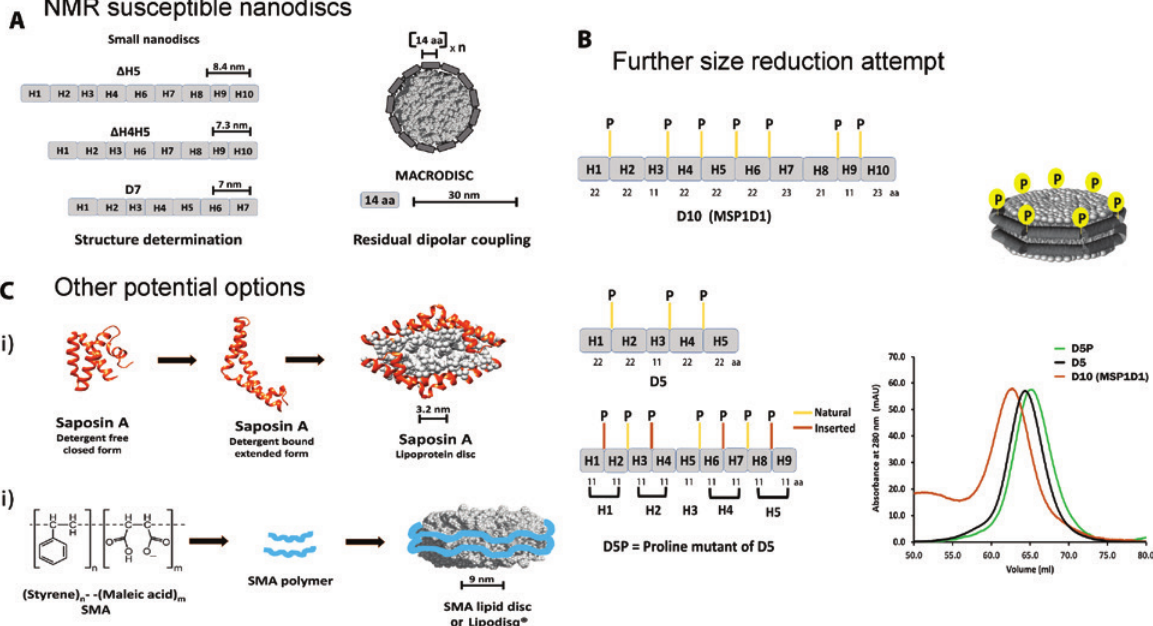
Figure 3: (A) Small nanodiscs that have been employed in solution NMR studies. Δ H5, Δ H4H5, and D7 provide discs with smaller diameters that can be used for structural investigation of encapsulated proteins (left panel). Pictorial representation of larger “MACRODISC” is shown where the outer annulus is formed by a 14 amino acid amphipathic peptide. This large 30 nm discs has been used to orient molecules for residual dipolar coupling experiments (right panel). (B) Schematic representation of MSP1D1/D10 with the positioning of prolines and the number of amino acids present in each helix. Pictorial representation of a nanodisc showing the presence of prolines at helix turns (top panel). A scheme for incorporating proline residues further forcing nanodisc to a smaller size is shown. An altered construct D5P, is created from D5 through the strategic placement of additional prolines, increasing the number of individual helices and potentially offering addi- tional turns at proline residues. Each individual helix in the D5P construct is of identical length and is maintained at a size of 11 amino acids, representing the smallest building block in the MSP1D1 construct (bottom left panel). The elution profile from size exclusion chromatogra- phy shows that the D5P nanodisc (green) is approximately the same size as D5 disc (black). Furthermore, D5 and D5P nanodiscs are similar in size to the MSP1D1/D10 discs (brown) (bottom right panel). (C) Alternative nanoscale phospholipid bilayer systems: saposin-A lipoprotein disc formed by the addition of detergent molecules is shown. Saposin-A in its detergent free form adopts a closed conformation which becomes extended when bound to detergent molecules (PDB ID: 4DDJ). Saposin-A lipoprotein disc, with a diameter of 3.2 nm, is formed when two saposin-A proteins are brought together by its lipid core (top panel). Styrene maleic acid lipid particle (SMALP) is shown where the synthetic styrene-maleic acid (SMA) copolymer forms a disc by encapsulating lipids within its central cavity. SMA lipid disc or Lipodisq ® have a diameter of 9 nm (bottom